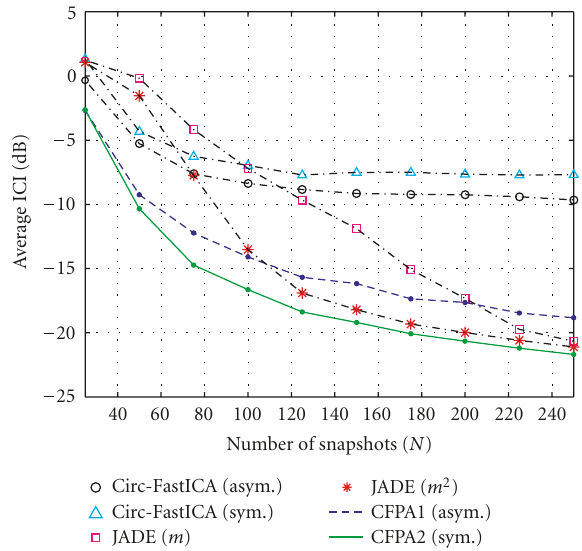
Figure 1: Average ICI as a function of data-record length N for the various algorithms on a noiseless six-source demixing